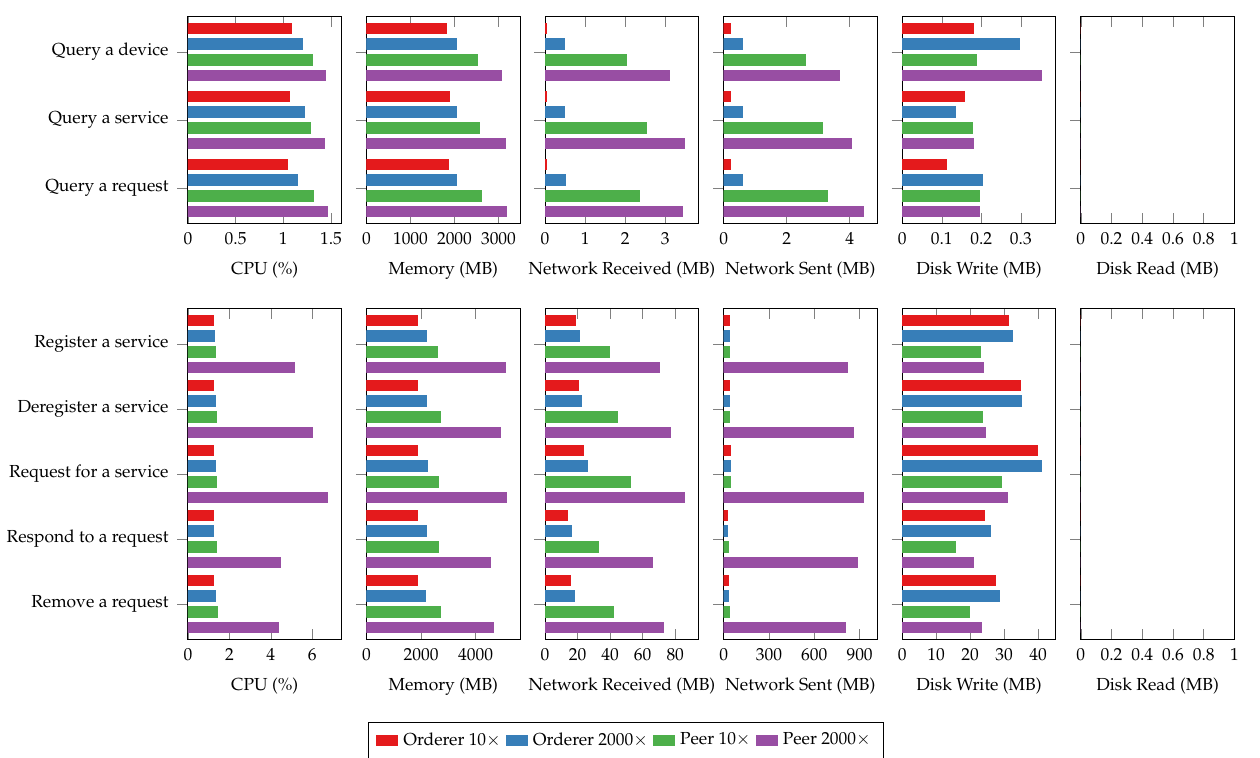
Figure 20. Average system resource utilization of orderer and peer nodes for 10 client connections (10 × ) and 2000 client connections (2000 × ).